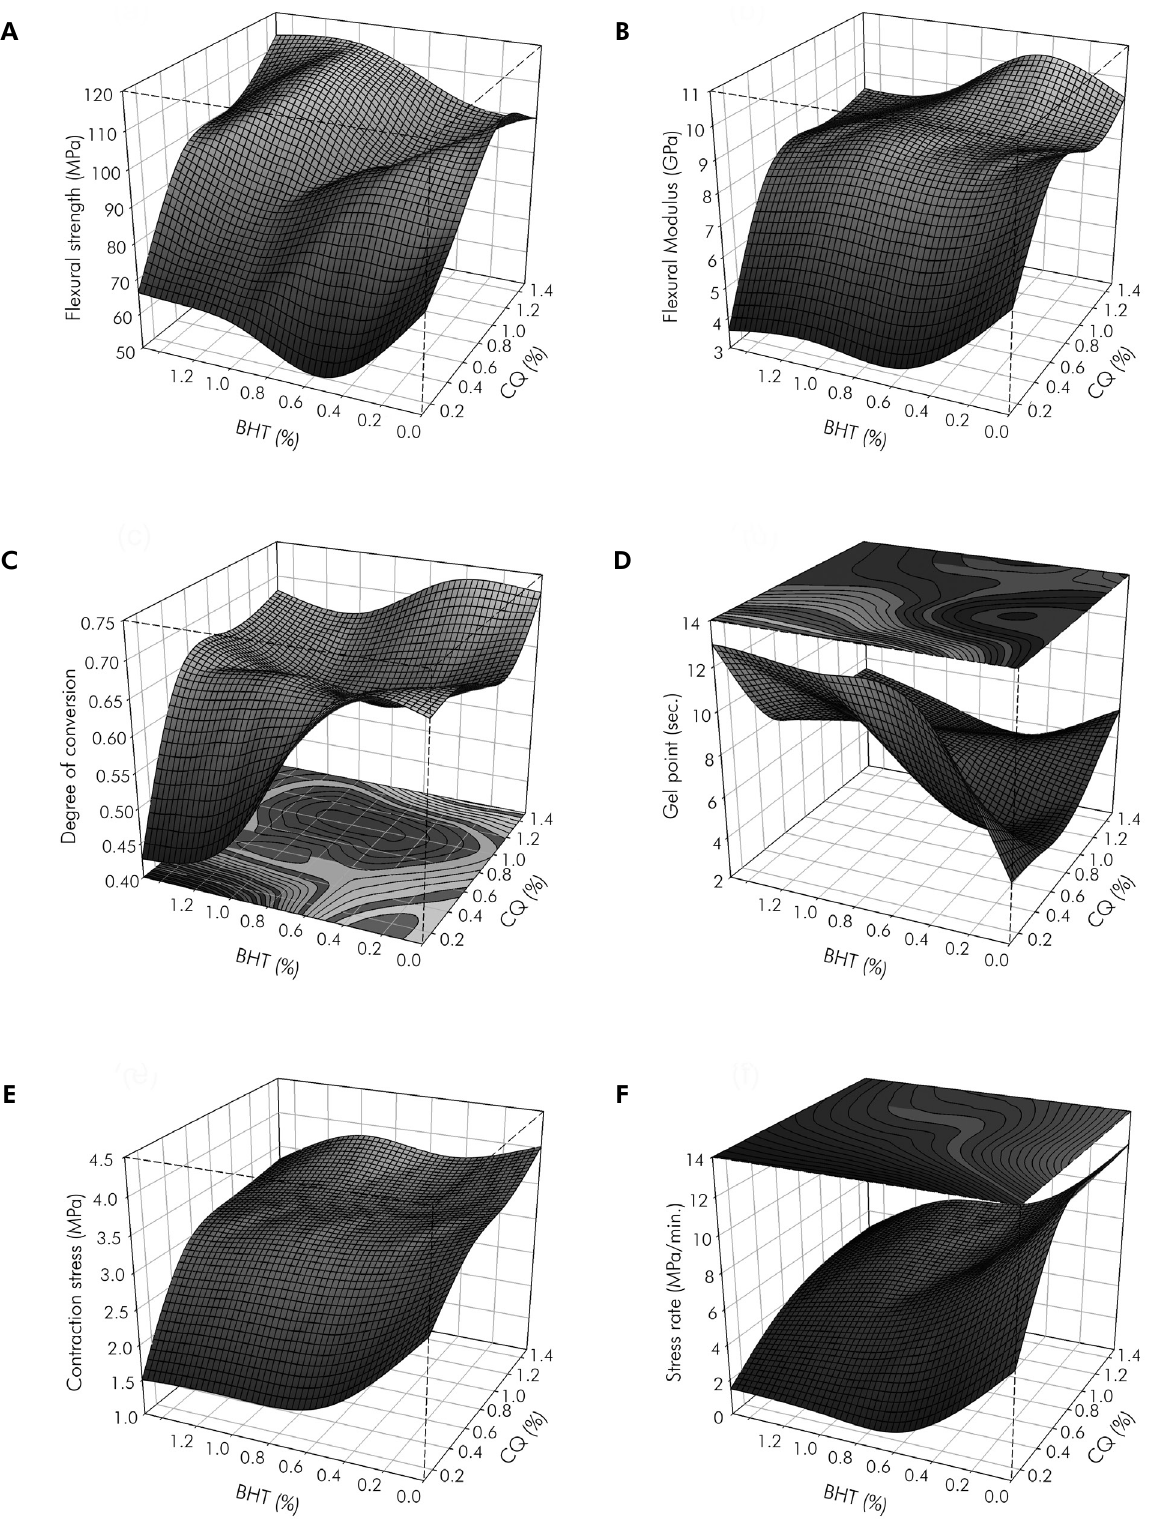
Figure 1. Iso-contour 3D map plots showing the interaction of different camphorquinone (CQ) and butylhydroxytoluene (BHT) combinations on the values of (a) flexural strength, (b) flexural modulus, (c) degree of conversion, (d) gel point, (e) contraction stress, and (f) stress